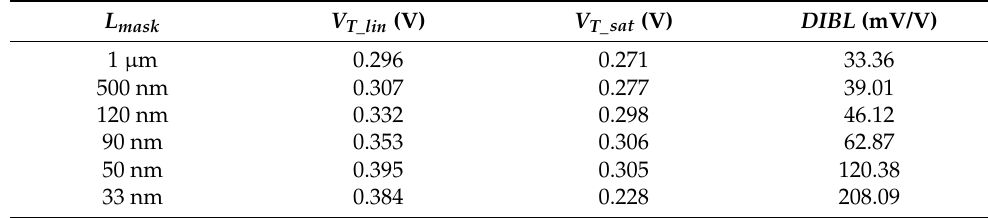
Table 4. The DIBL effect with different channel